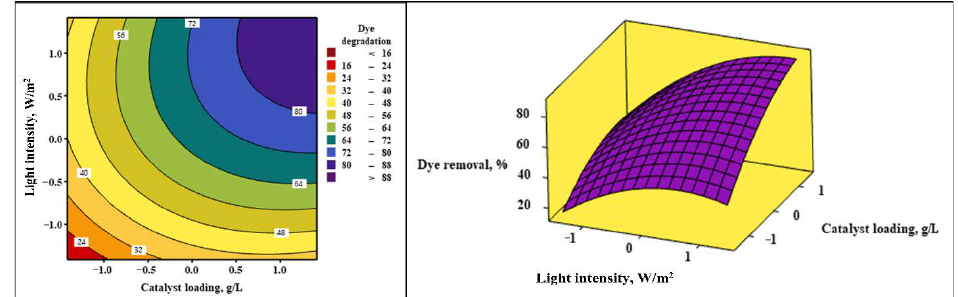
Figure 10. Surface response and contour plot of DB15 removal as a function of catalyst and light intensity (dye concentration is held at its respective center